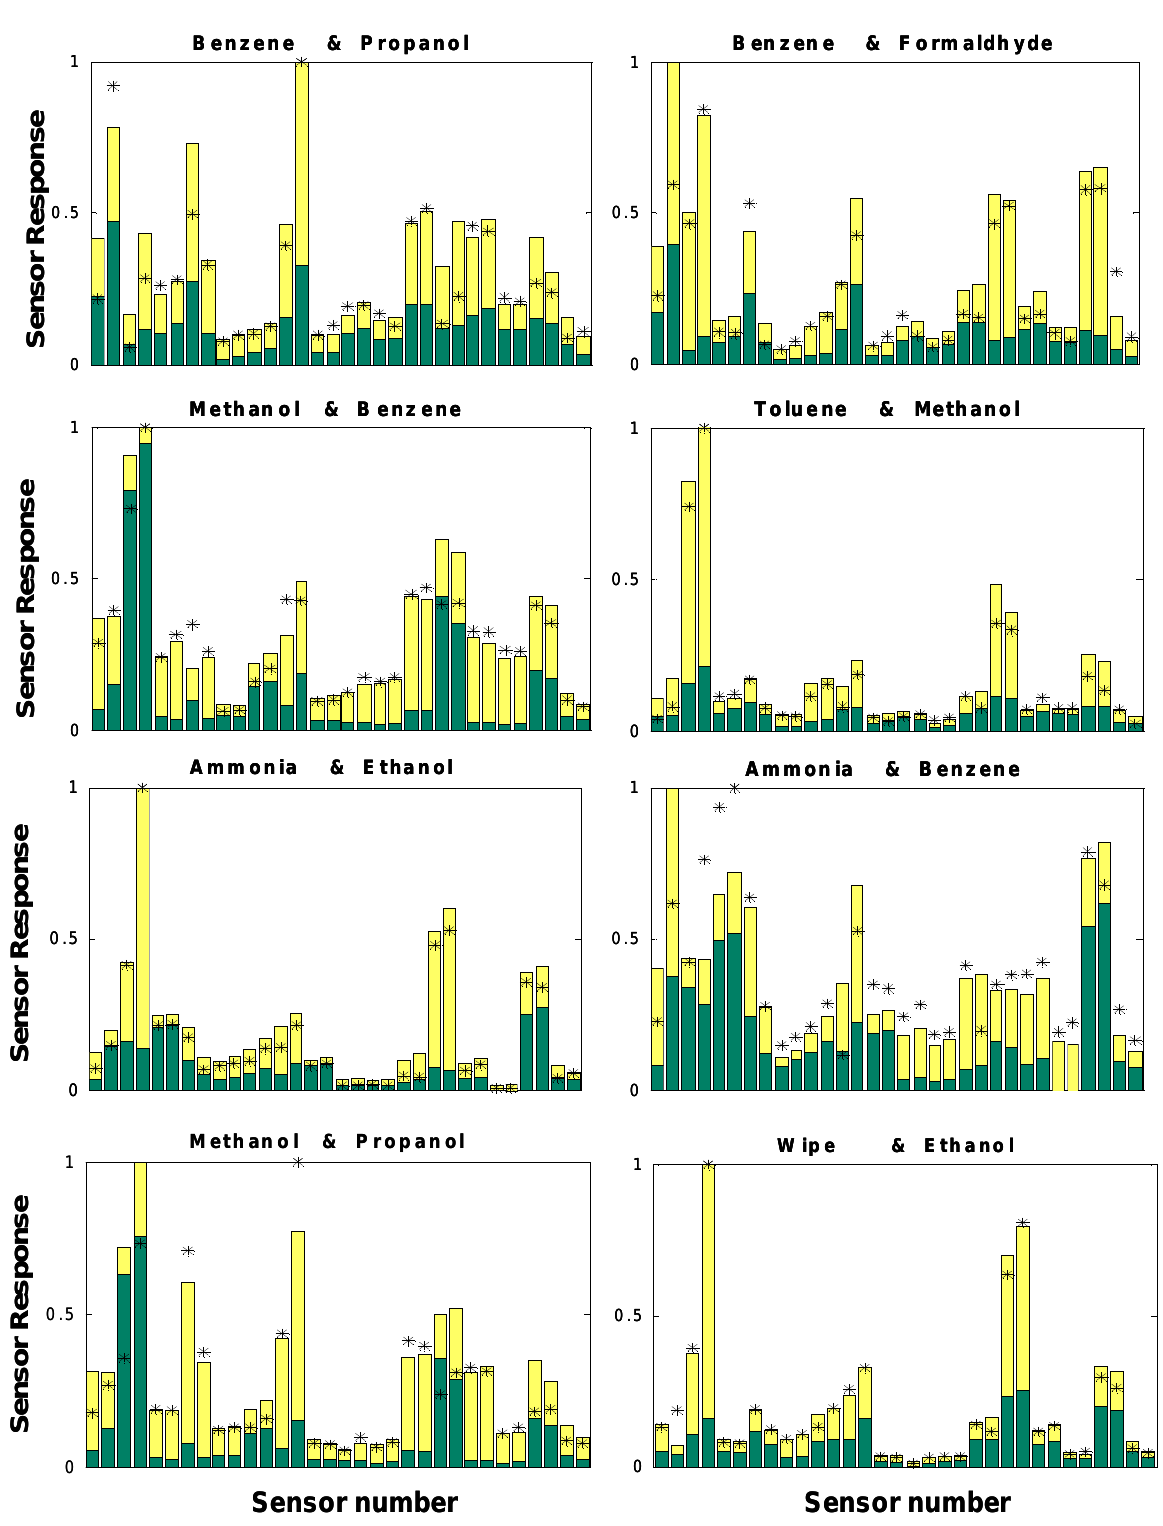
Figure 3. Linear additive of responses roughly holds for the mixture pairs of gas compounds tested. The bars indicate the expected mixture signatures and each components contribution from the corresponding singles. The first component (as specified in title): lower, darker portion of the bar; second component : upper, lighter portion of the bar. Stars represents actual response patterns to the mixtures generated by the ENose sensor. Vertical axes: normalized resistance change; horizontal axes: sensor sequence